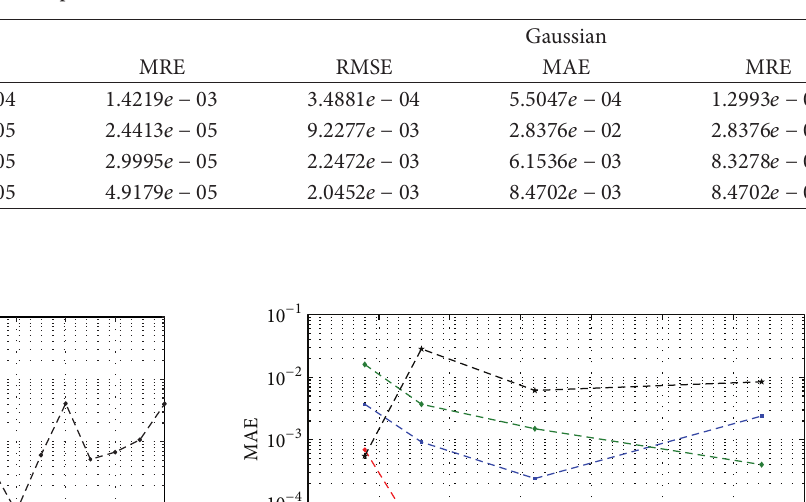
Table 2: Error comparison between MQ method and Gaussian method.